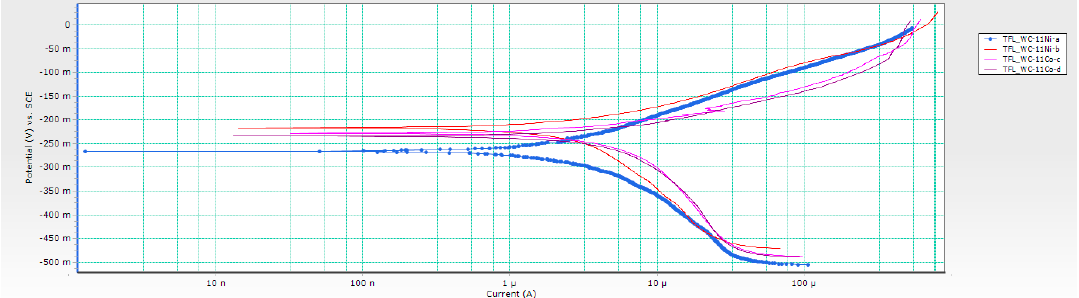
Figure 4. Tafel extrapolation curves of samples.